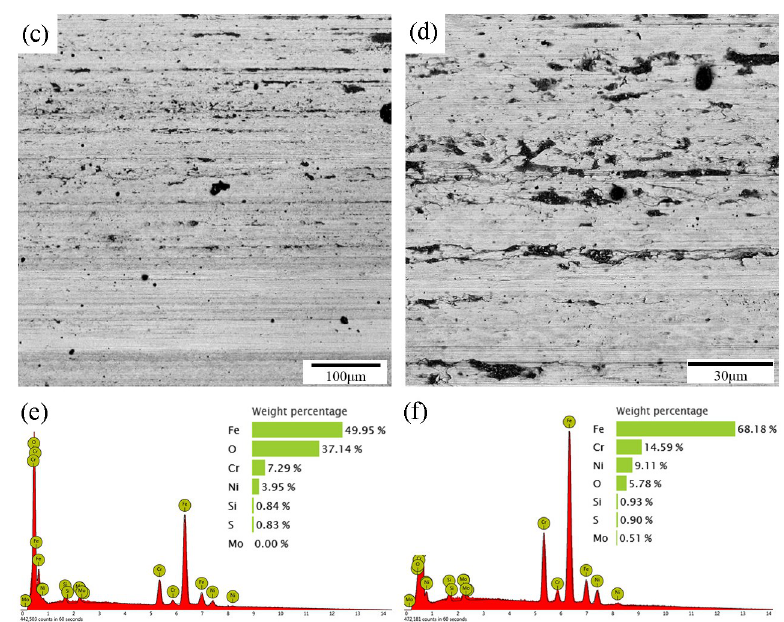
Figure 6. SEM images of the typical worn surfaces of the USR sample at 200 rpm ( a , b ) and 400 rpm ( c , d ). The right-hand graph is an enlargement of the left-hand graph. The result of EDS analysis ( e , f ), obtained from the region marked by 1 and 2 in ( b ).